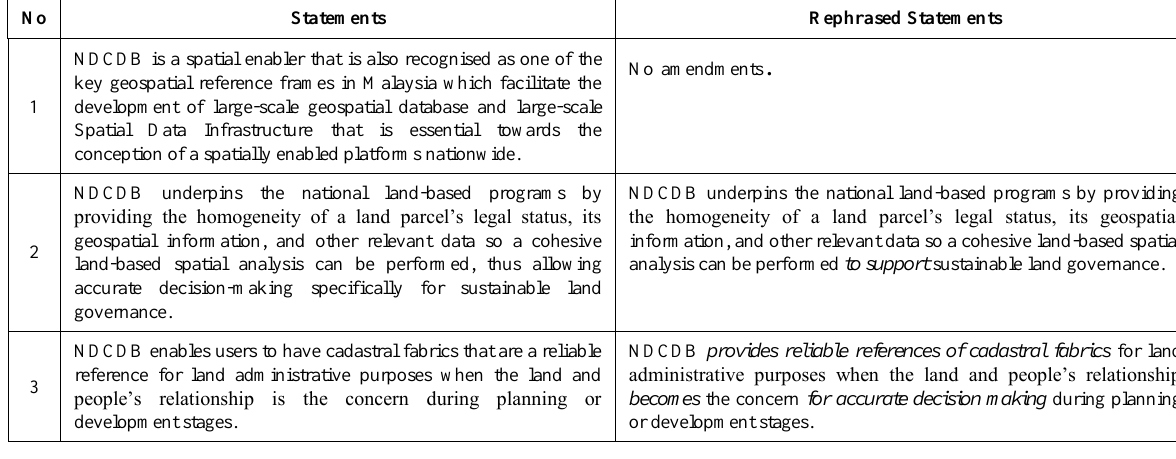
Table 6: Round 2 statements on NDCDB‘s significant role in Malaysia